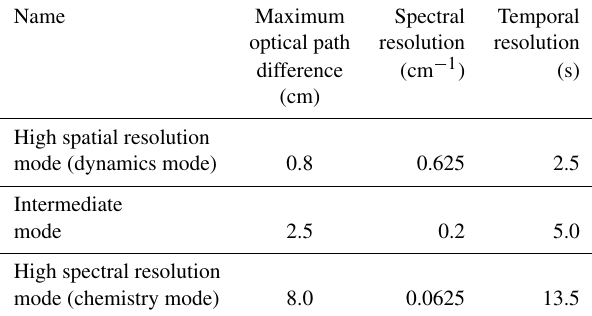
Table 1. Typical operating modes of GLORIA. The actual optical path difference is typically longer than the nominal one. Approxi- mate values for the temporal resolution are given as it partially de- pends on the configuration of the